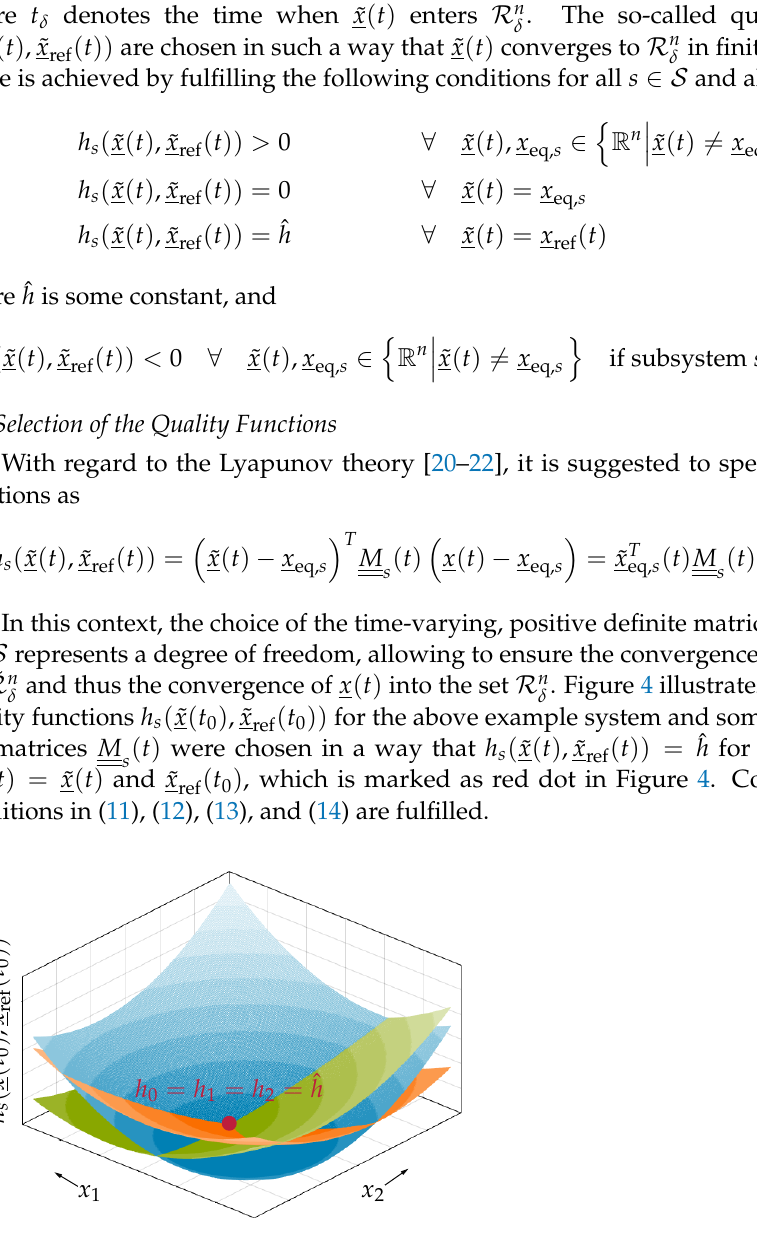
Figure 4. Quality function h s ( ˜ x ( t 0 ) , ˜ x ref ( t 0 )) for all s ∈ S = { 0,1,2 } with t 0 >